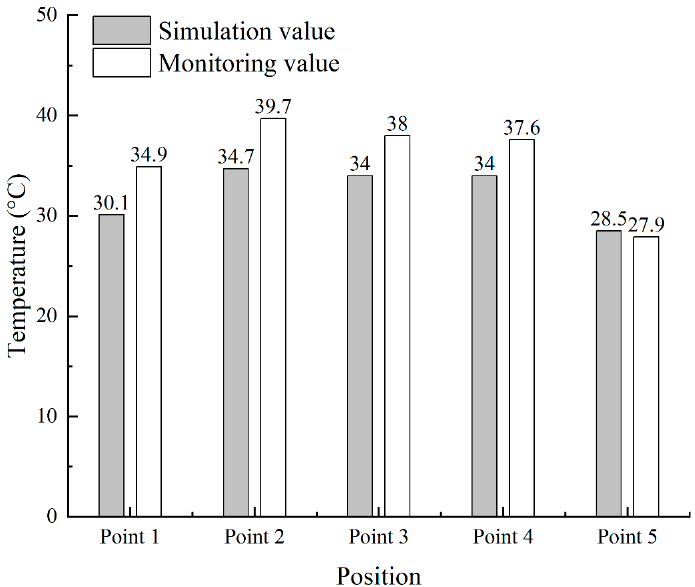
Figure 9. Comparison of calculated and monitored temperature values of bedrock before impound- ment.